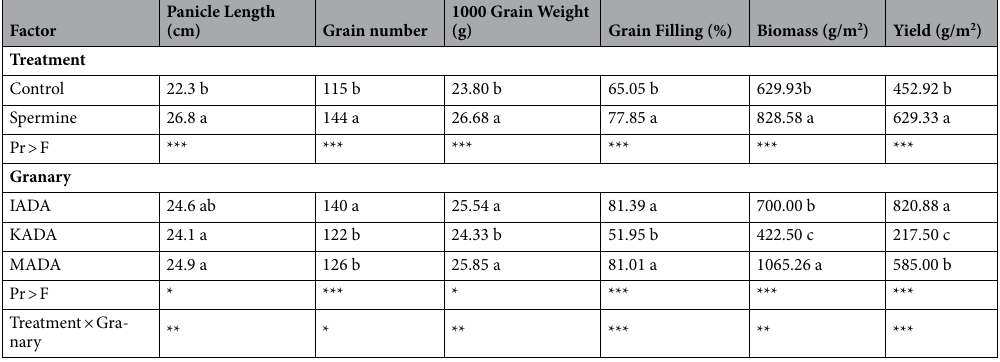
Table 8. Main and interaction effects of treatment and granary on yield components of rice variety. Means followed by the same letter in the same column are not significantly different at p ≤ 0.05 according to Fisher’s least significant difference (LSD).ns indicates non-significant difference at P > 0.05, * significant difference at P ≤ 0.05, ** significant difference at P ≤ 0.01 and *** significant difference P ≤ 0.001. IADA BLS: Integrated